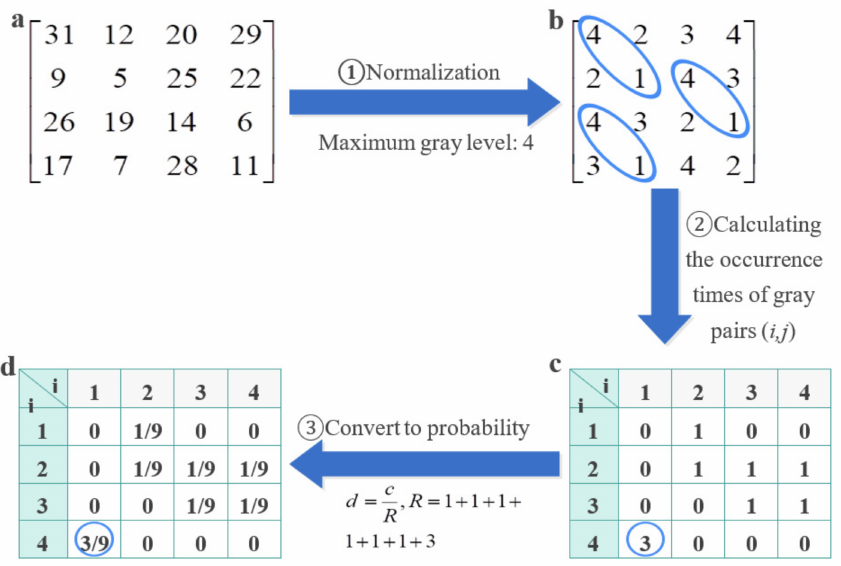
Figure 4. Typical GLCM calculation process. ( a ) The original thermal image is transformed into a gray matrix, and P ( i,j ,(1,1), 135 ◦ ) is calculated. ( b ) Normalization of the original matrix to the specified gray scale range. ( c ) Counting the occurrence times of gray pair ( i , j ) at the two adjacent pixels on the 135 ◦ diagonal. ( d ) Calculation of the occurrence probability of each pair of pixels ( i , j ), namely,